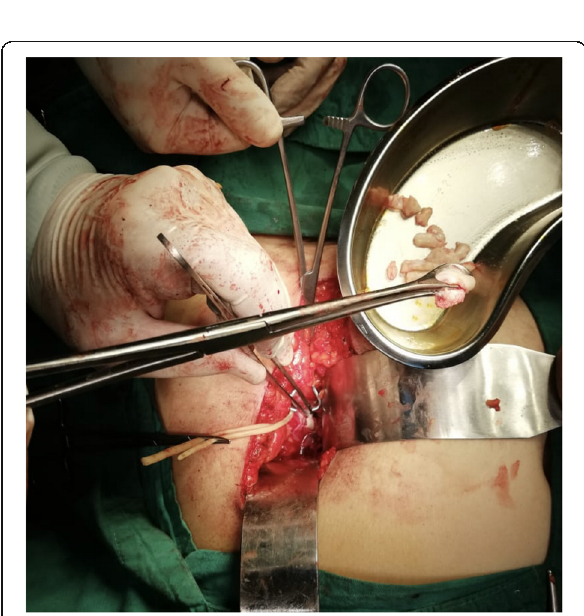
Fig. 3 An intraoperative picture showing the hydatid cyst and the daughter cyst extracted from its